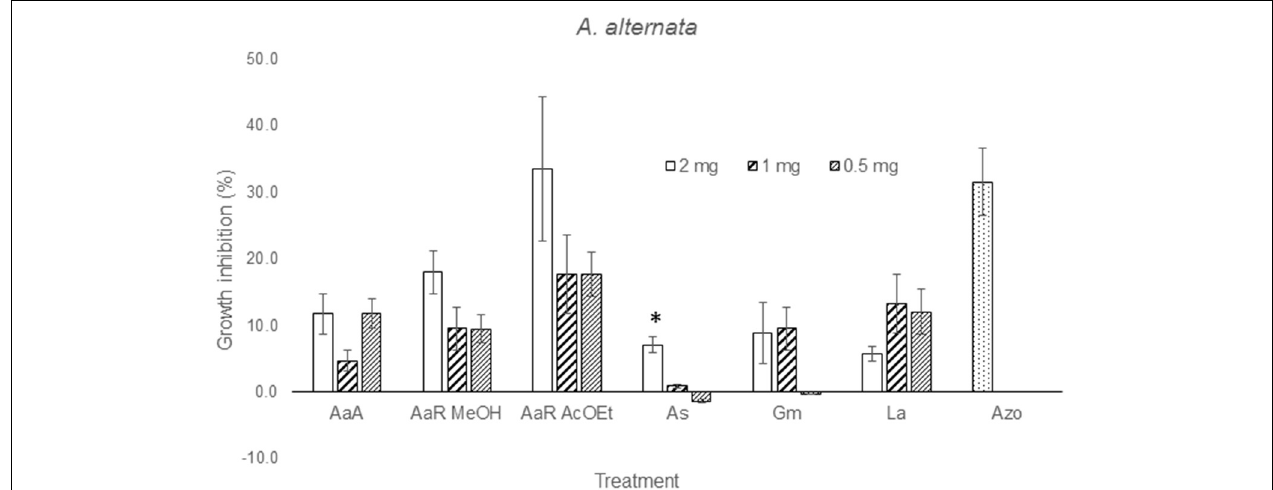
FIGURE 3 | Zone of inhibition (%) due to methanol extracts of aerial part (AaA) and roots (AaR MeOH and AaR AcOEt) of A. aurantium , aerial parts of A. subviscida (As), G. mexicanum (Gm), and L. achyranthifolia (La) at different concentrations against A. alternata .